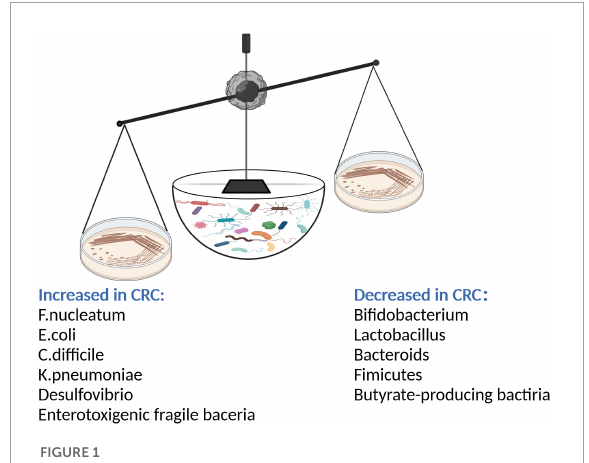
FIGURE1 After gut microbiota imbalance, intestinal probiotics such as Bifidobacterium , Lactobacillus , Bacteroides, butyrate-producing bacteria decreased; the number of pathogenic bacteria such as Fusobacterium nucleatum, Enterotoxigenic fragile bacteria, Escherichia coli , Clostridium difficile , Klebsiella pneumonia , Desulphurization increased. The pathogenic bacteria secreted a large number of toxic factors to damage intestinal epithelial cells and promote the occurrence of